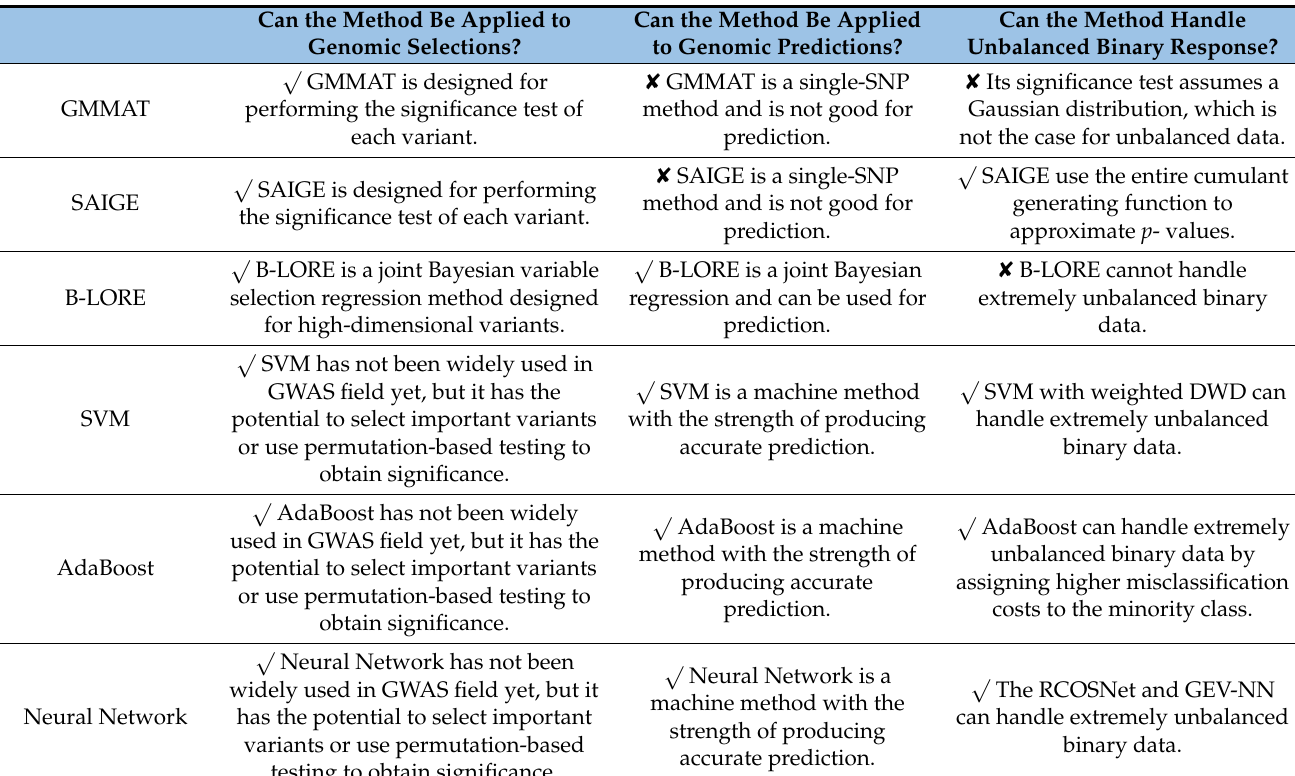
Table 2. A summarization of the methods evaluated from different aspects mentioned in the manuscript. Each method has its own advantages and